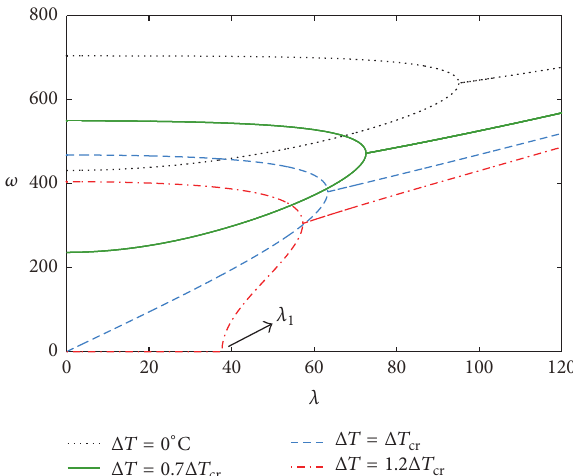
Figure7:Naturalfrequenciesversusdynamicpressureunderdiffer- ent temperature